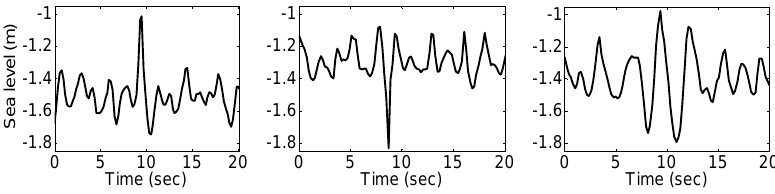
Figure 3. Typical positive (left), negative (middle) and sign-variable (right) shape of freak waves in Tallinn bay occurred at 4:06 on 22 June, at 4:27 on 24 June and at 3:55 on 26 June 2008, respectively; the sea level is measured relative to the location of the echosounder. 50% higher than its trough with respect to the mean sea level.